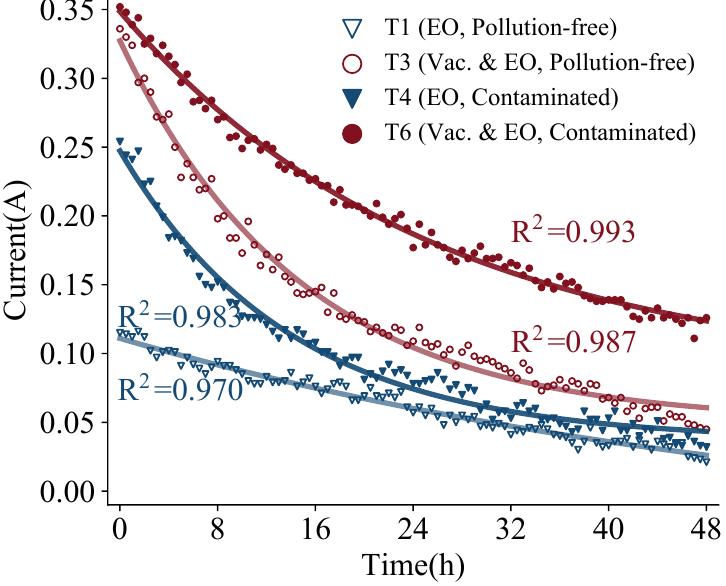
Figure 15. Change curve of current with